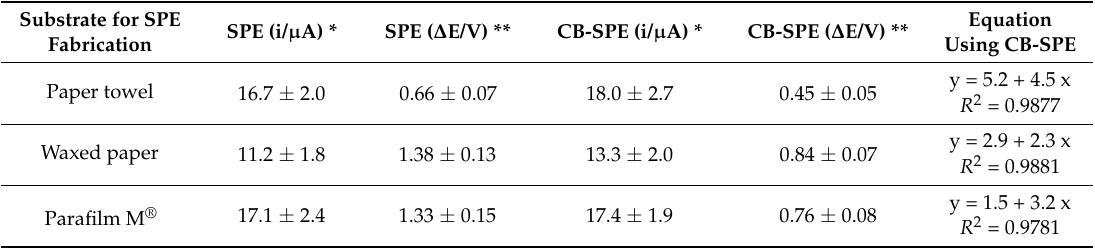
Table 1. Summary of electrochemical parameters for SPEs fabricated onto paper towel, waxed paper, and Parafilm M ® , before (SPE) and after (CB-SPE) the modification with 2 µ L of a CB dispersion. Substrate for SPE Fabrication